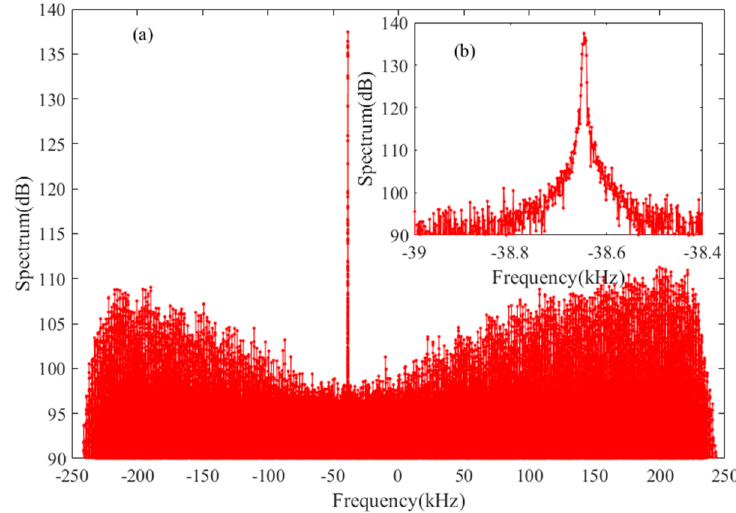
Figure 5. Spectrum of MEX observed at the JM station on 28 June 2020, with sampling frequency of 500 kHz ( a ) the whole spectrum ( b ) the enlarged view of carrier zone.